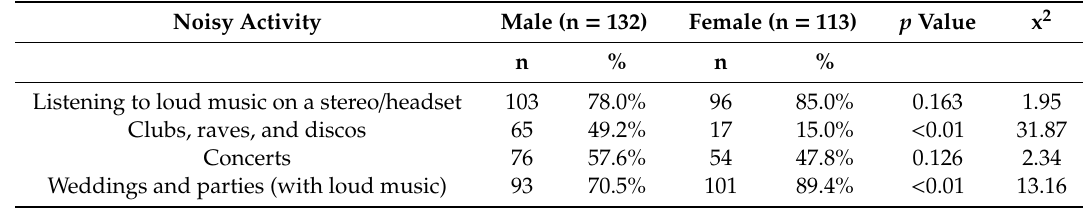
Table 2. Distribution of the students’ participation in the di ff erent noisy